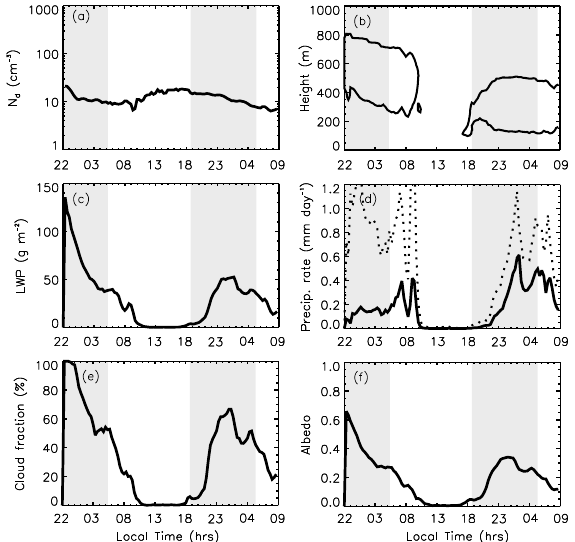
Fig. 2. Time evolution of domain averaged cloud properties for the WP control case. (a) Cloud droplet number concentration ( N d , cm − 3 ) ; (b) cloud top and cloud base height (contour at cloud wa- ) ; (c) liquid water path (LWP, g ter mixing ratio of 0.01gkg − 1 dry air m − 2 ) ; (d) surface rain rate (solid), and cloud base rain rate (dotted) (mm day − 1 ) ; (e) cloud fraction (%); and (f) cloud albedo. Shading indicates the night. Fig. 3. Time evolution of domain averaged dynamic and physical properties for the WP control case. (a) Vertical velocity variance ( <w 0 2 > , m 2 s − 2 ) ; (b) vertical velocity skewness; (c) radiative heat- ing rate (K day − 1 ) ; (d) buoyancy (cm 2 s − 3 ) ; (e) resolved turbulent kinetic energy (m 2 s − 2 ) ; (f) sub-grid scale turbulent kinetic energy ) ; and (h) potential (m 2 s − 2 ) ; (g) total water mixing ratio (g kg − 1 dry air temperature (K). Solid lines indicate the cloud top and cloud base ) . height (a contour at cloud water mixing ratio of 0.01gkg − 1 dry air Hatch lines indicates the